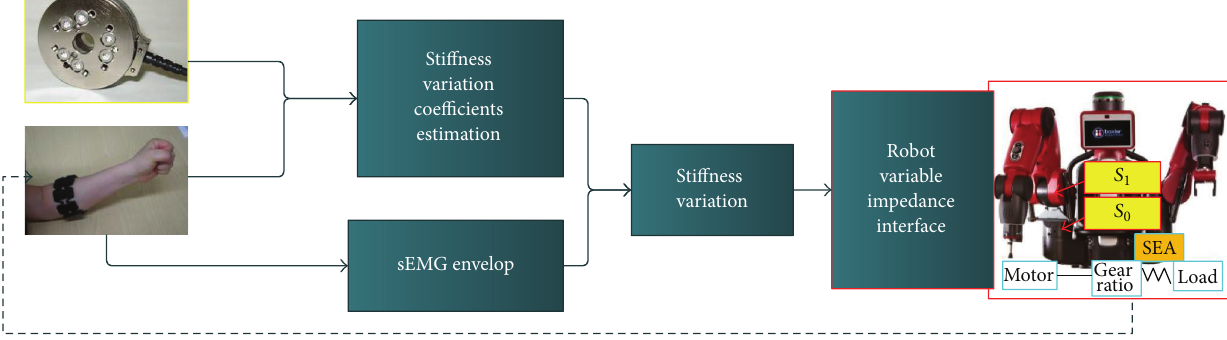
Figure7:Overallexperimentalsystemset-updatafromforcesensorandArmbandareemployedtoestimatestiffnesscoefficientsandstiffness variation is estimated from sEMG envelop procedure and then transferred to robot joint by variable impedance interface.